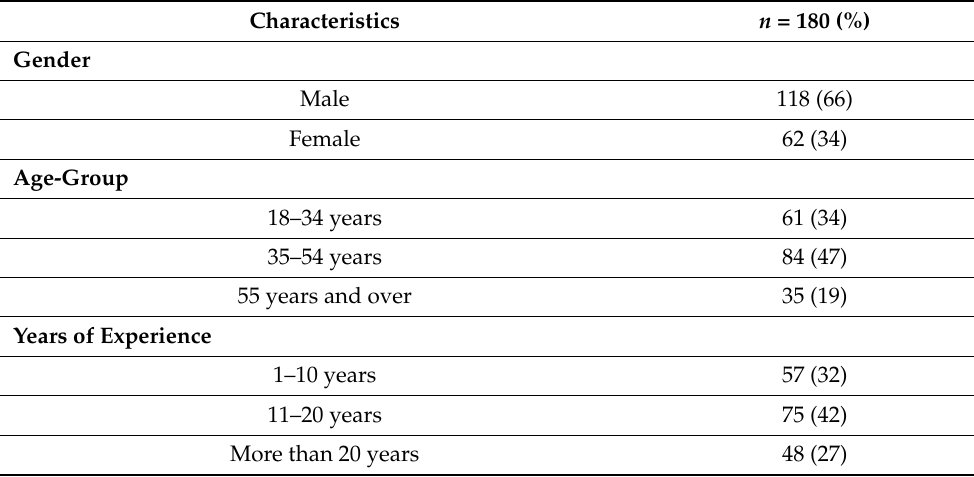
Table 1. Characteristics of study